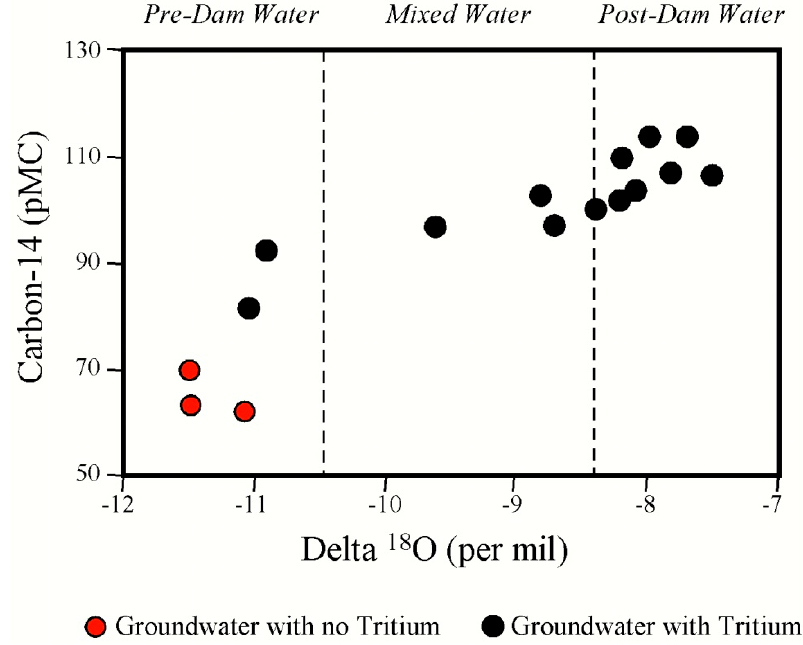
Figure 6. Water isotope and carbon-14 scatter plot using data from Table 2. A clear relationship is observed between isotopically light and older groundwater defined by carbon-14. Stippled vertical lines define dominant water types in the data set.